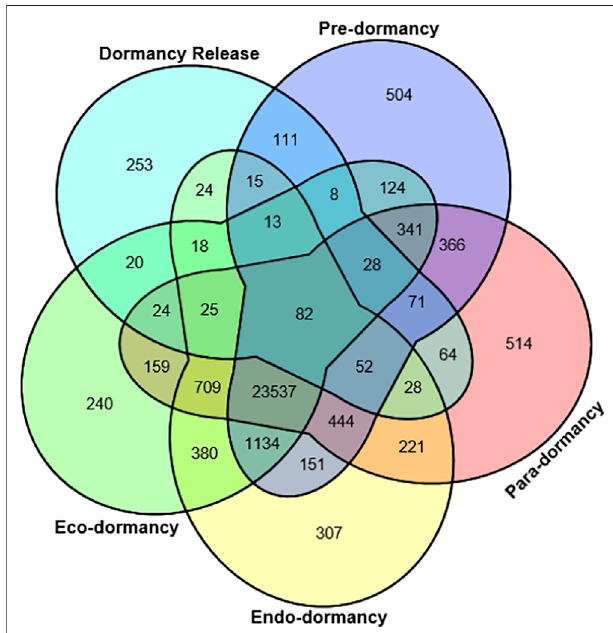
FIGURE5| Venndiagram representing common and uniquetranscripts among multiple dormancy stages, viz , pre-dormancy, para-dormancy, eco- dormancy, endo-dormancy, and dormancy release.